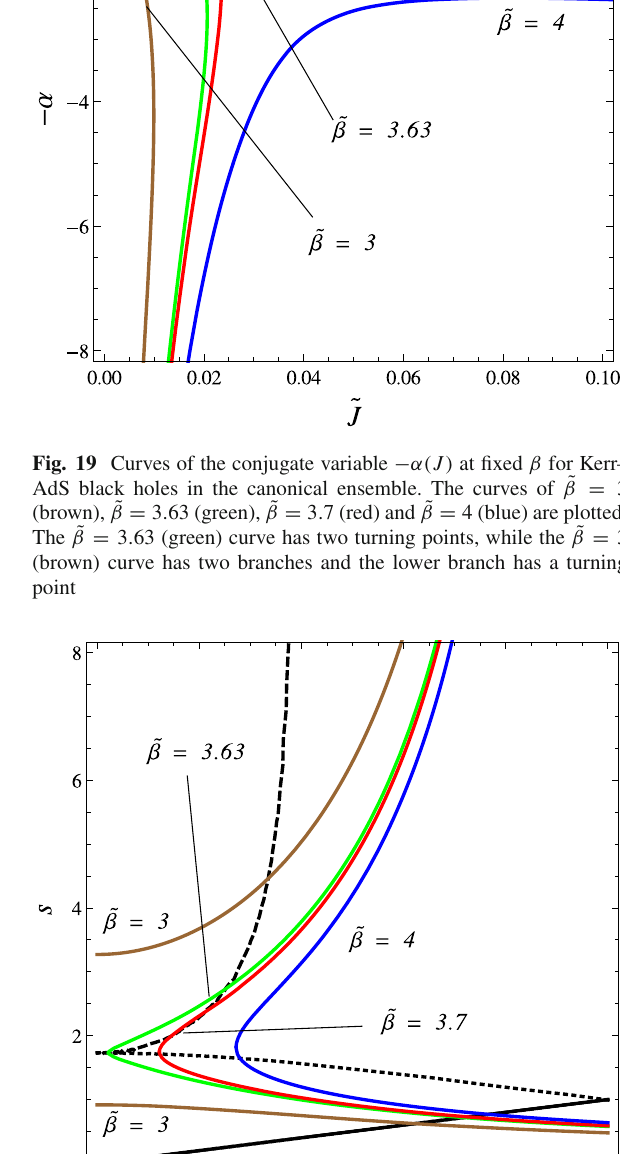
stant β . The curves of constant β on the ( p , s ) space are plotted on Fig. 20. There are no turning points on the lower temperature (larger β ) curves, but higher temperature